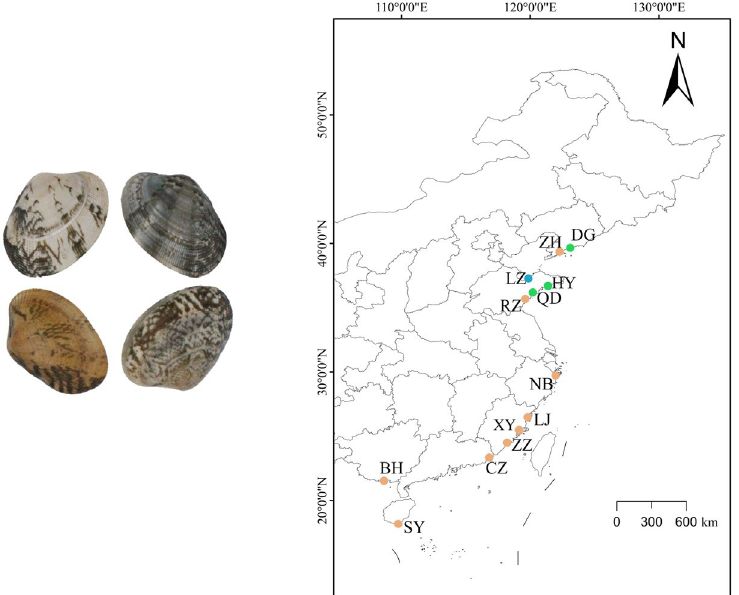
Figure 1. The sampled location for the Manila clam ( Ruditapes philippinarum ) along the coast of China. The map of the People’s Republic of China is downloaded from the website of http://bzdt.ch.mnr.gov.cn/, accessed on 7 December 2021. The color dots representing the three groups revealed by the PCoA analysis: blue (LZ), green (DG, HY, QD), and orange (ZH, RZ, NB, LJ, XY, ZZ, CZ, BH, and SY). Table 1. Sample code, location, collection date, and sample sizes for all populations of R. philippinarum.